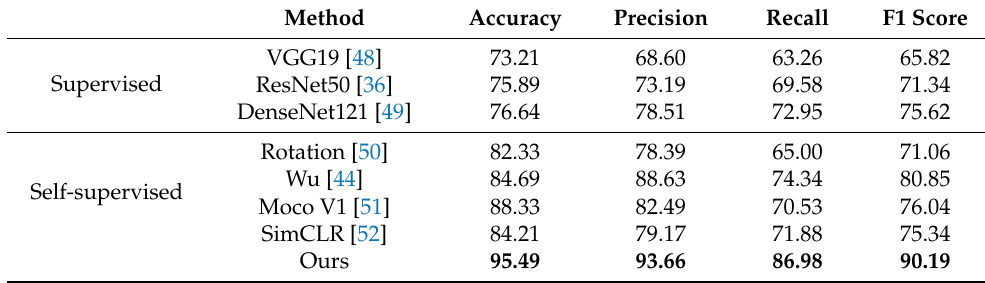
Table 3. Comparison of Different Methods in COVID-19 Severity Classification